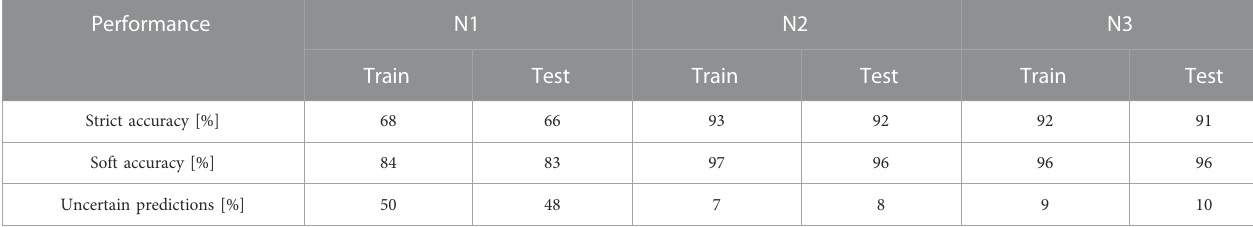
TABLE 4 Numerical case study: performances of networks N1, N2 and N3 for the dataset of model S.